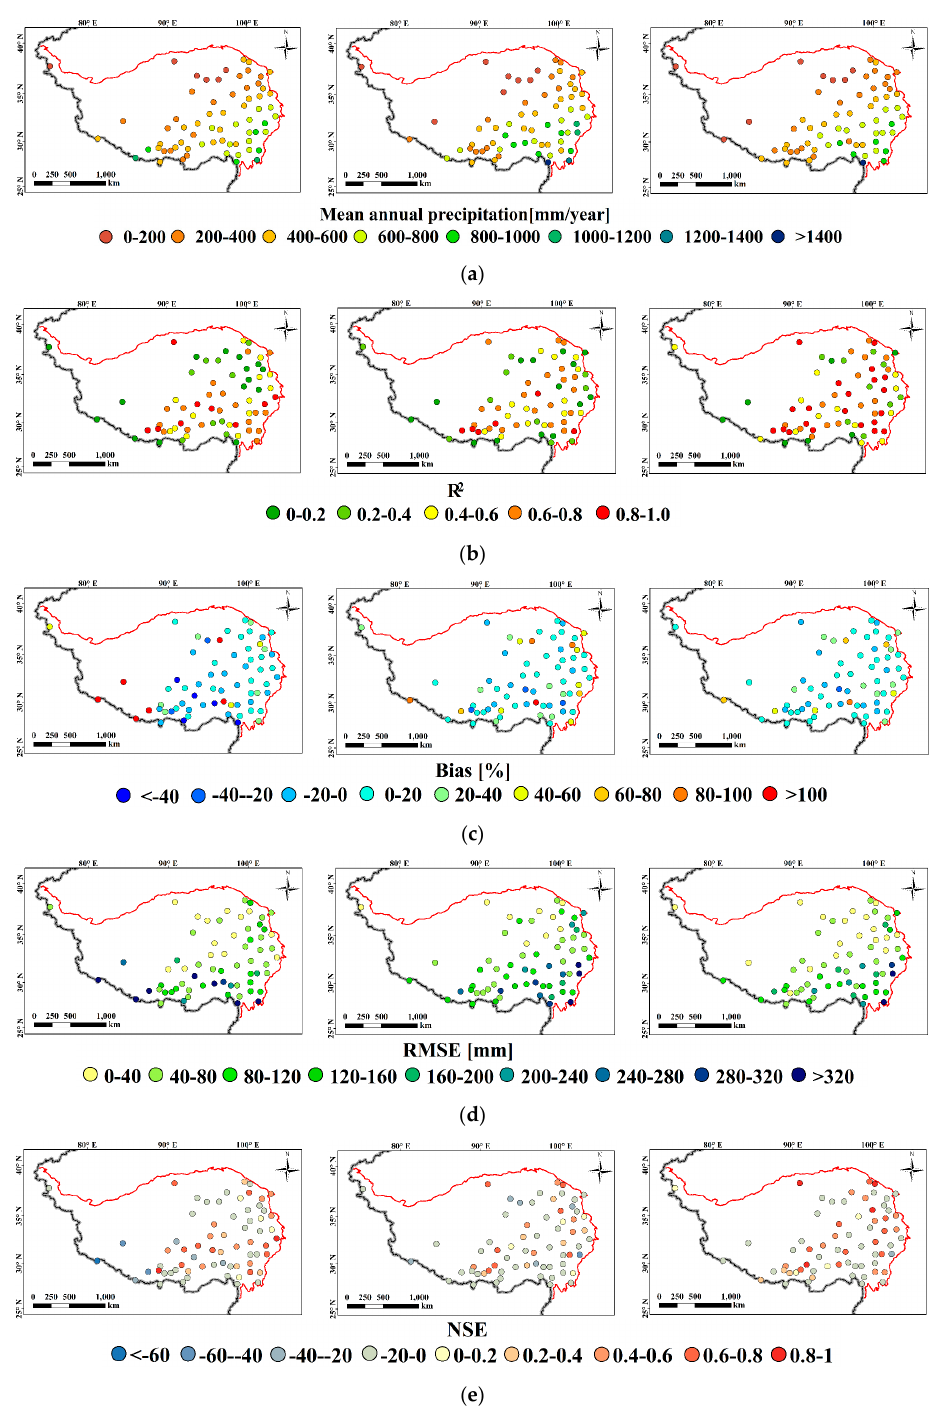
Figure 9. Spatial distributions of ( a ) mean annual precipitation obtained from CHIRPS (left column), DS without gauge calibration (the central column) and DS with gauge calibration (right column), ( b ) R 2 , ( c ) bias, ( d ) RMSE, ( e ) NSE, of CHIRPS, DS without gauge calibration and DS with gauge calibration, against ground observations, from 1990 to 1999, over the